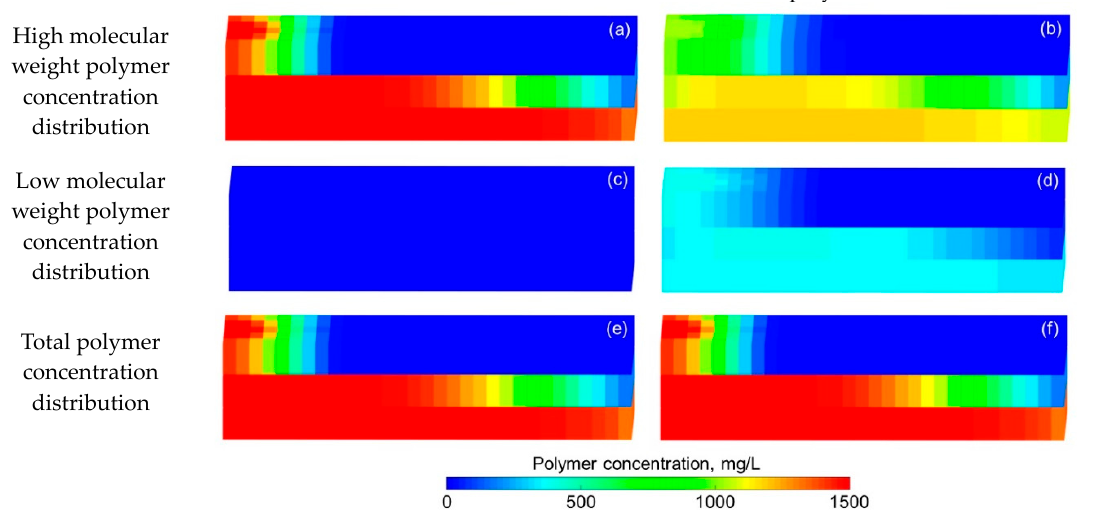
Figure 13. 3D ( a ) high molecular weight, ( c ) low molecular weight, and ( e ) total polymer concentration distributions after injection of 0.64 PV polymer solution, and 3D ( b ) high molecular weight, ( d ) low molecular weight, and ( f ) total polymer concentration distributions at 120 days after injection of 0.64 PV polymer solution by the designed simulator in simulating the polymer flooding experiment.